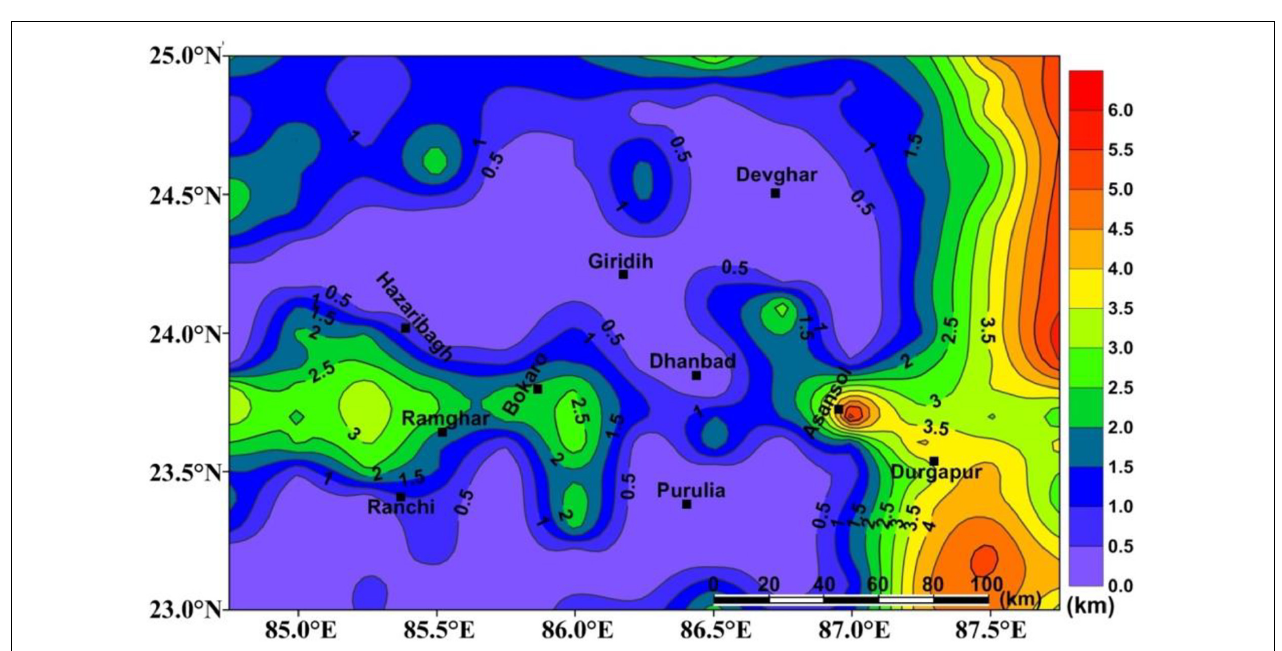
FIGURE 8 | Sediment depth map deduced from spectral analysis, with a contour interval of 0.5 km.